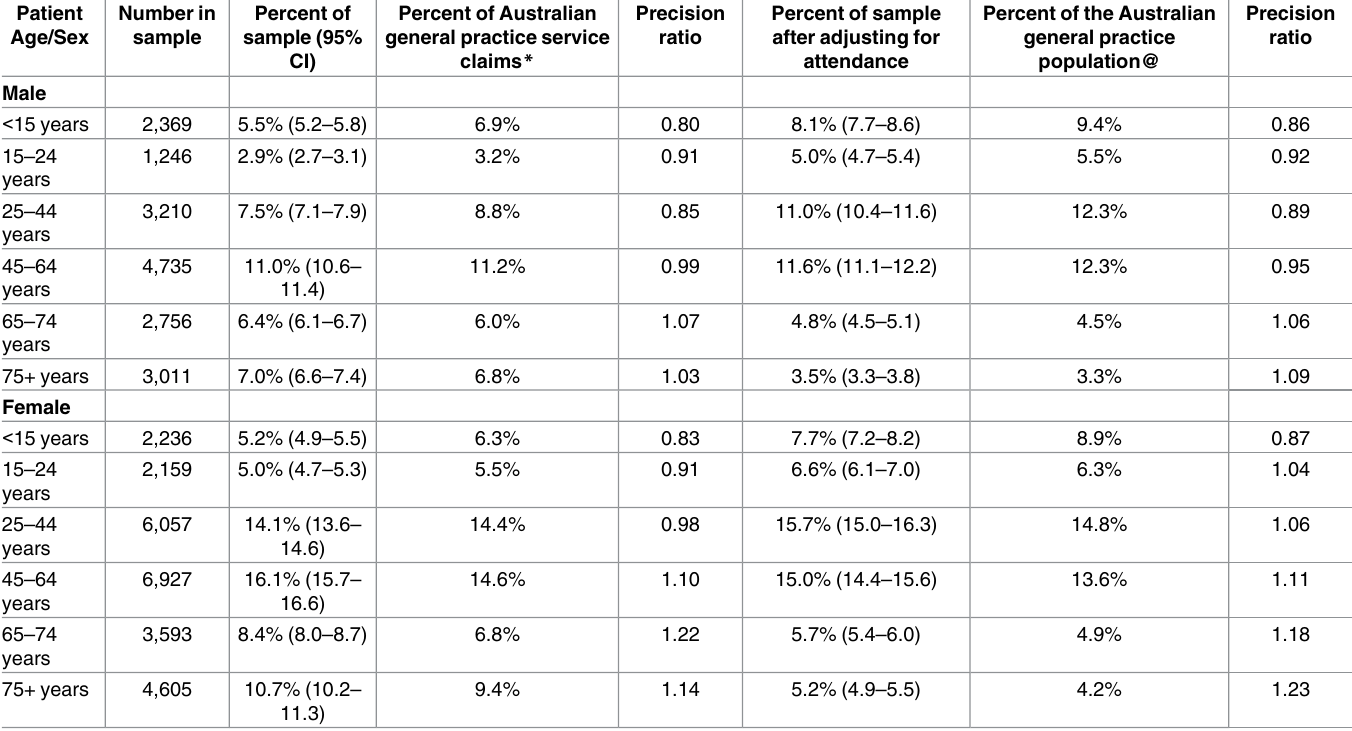
Table 2. Age-sexdistribution of the